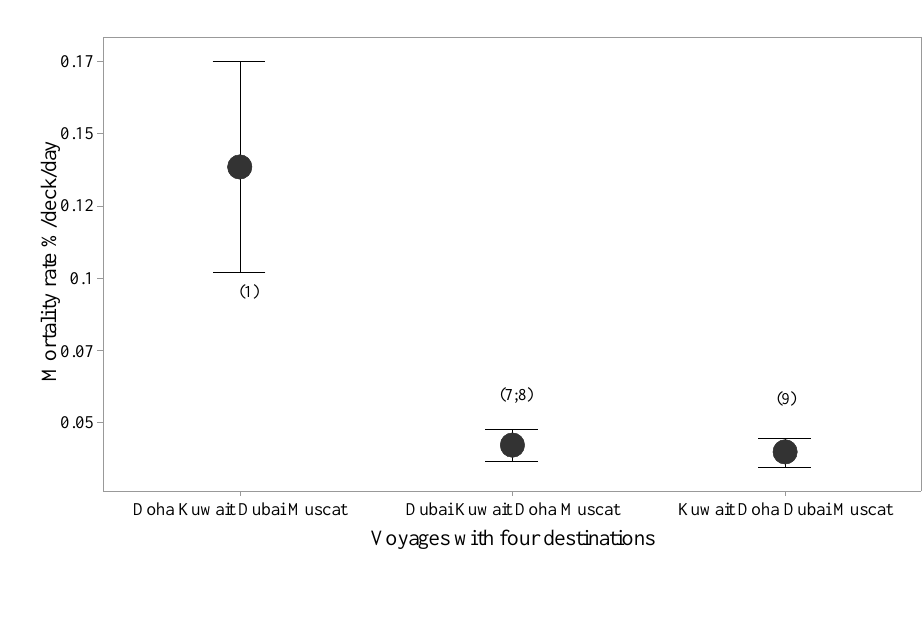
Figure 7. Mortality rate (%/deck/day with standard deviations) for voyages ( n = 4, numbers in parentheses) with four destination ports in different orders.